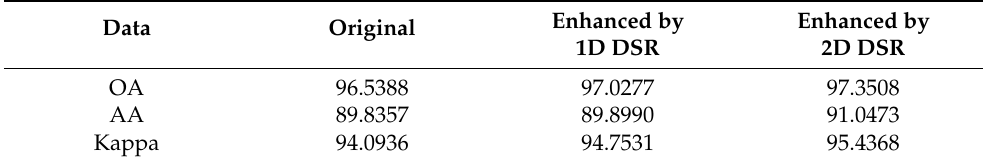
Figure 12. The 1 ST band of HYDICE enhanced by 1D and 2D DSR. ( a ) Original HYDICE; ( b ) 1D DSR; ( c ) 2D DSR. Table 4. Classification accuracy of different data by the